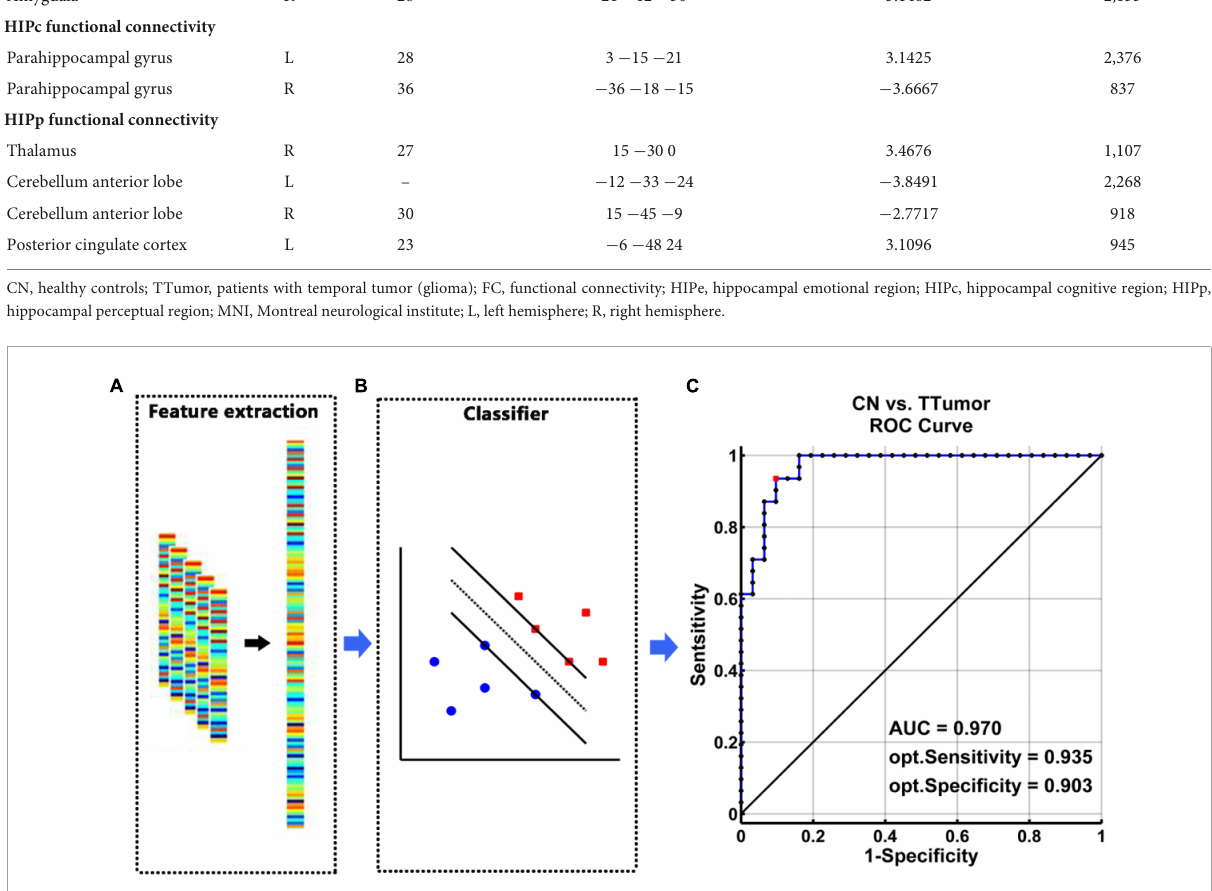
FIGURE3 The classification power of an MRI-based “classifier” in distinguishing individuals with TTumor from CN before surgery in the first cohort. (A) We extracted features based on FC of the altered hippocampal subnetworks in order to train the “classifier” model. (B) The schematic diagram indicated a support vector machine “classifier,” based on altered functional characteristics within the HIPe, HIPc, and HIPp subnetworks. (C) The ROC curve showed the classification power of the MRI-based “classifier.” The values of AUC, sensitivity, and specificity are marked in the lower right of the figure. CN, healthy controls; TTumor, patients with temporal tumor (glioma); HIPe, hippocampal emotional region; HIPc, hippocampal cognitive region; HIPp, hippocampal perceptual region; AUC, area under the curve; FC, functional connectivity; opt,